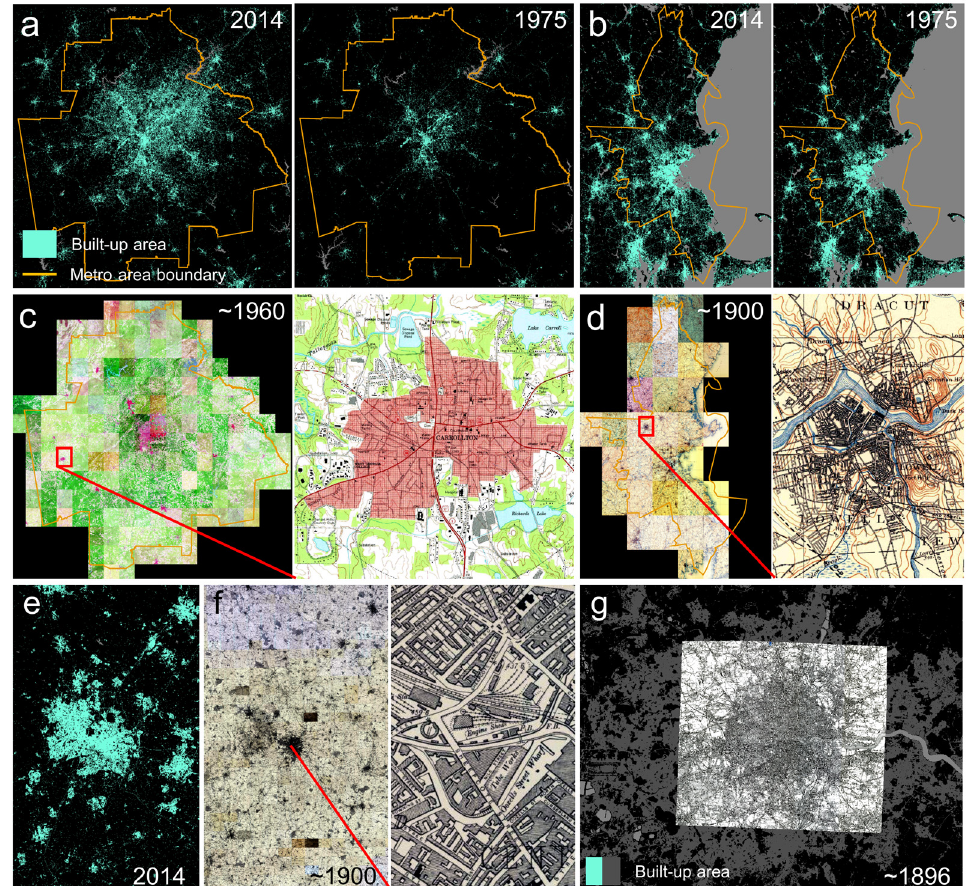
Figure 1. Input data for the study areas in the US and in the UK: ( a ) GHSL-based built-up area in 2014 and 1975 in Atlanta metro area (US), and ( b ) in the Boston metro area (US); ( c ) 1:24,000 historical map composite for the Atlanta metro area from approximately 1960, and ( d ) historical map composite for the Boston metro area at scale 1:62,500 from approximately 1900; ( e ) GHSL-based built-up area in 2014 in the greater Birmingham area (UK), ( f ) historical Ordnance Survey topographic map composite from approximately 1900 (approximate scale: 1:10,000), with an enlargement of a part of the Birmingham downtown area, and ( g ) historical Ordnance Survey topographic map composite from 1896 for the London area (UK; approximate scale: 1:63,000), overlaid on the GHSL 2014 built-up areas (grey).